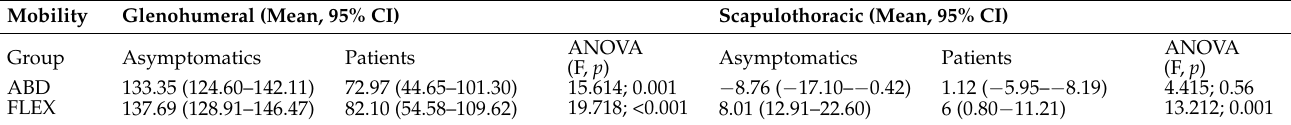
Table 1. Mean (95% CI) joint angular mobility ( ◦ ) from each axis in abduction and